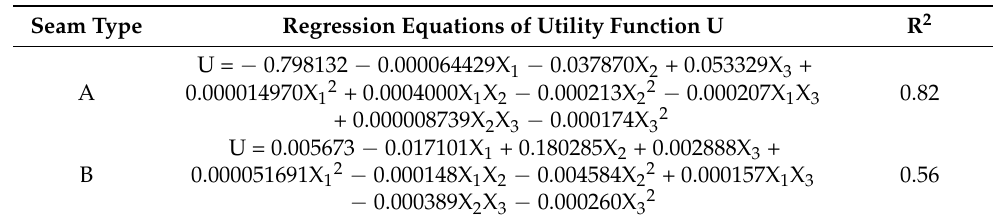
Table 2. Regression equations describing utility function U vs. lamination process parameters (T, t, p ) for seam A and seam